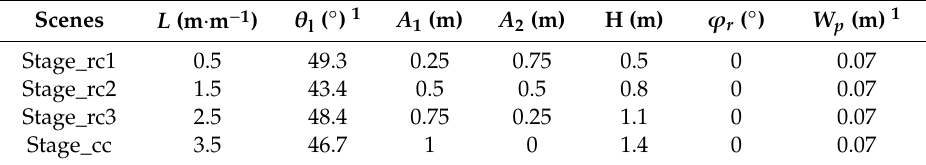
Figure 4. The abstract scenes of row crops. ( a ) The proportion of between-row dominance (Stage_rc1), ( b ) proportions of between-row and canopy closure equality (Stage_rc2), ( c ) proportion of the canopy closure dominance (Stage_rc3), and ( d ) continuous crops (Stage_cc). Table 1. Values required when constructing abstract scenes with computer